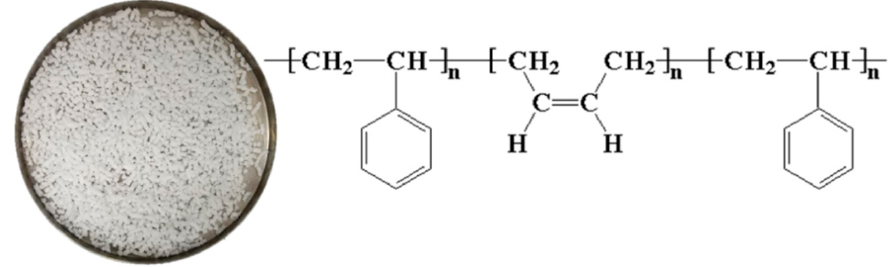
Figure 1. Appearance of original SBS copolymer. Table 1. Basic properties of SBS copolymer.